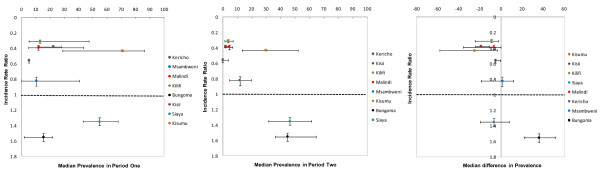
Relationship between changes in the incidence rate of malaria admissions between period one and two (Incidence rate ratio) and equivalent absoulte changes in transmission intensity across 8 hospital sites in Kenya (Left-starting PfPR; Middle - PfPR at the end of the study and Right - absolute difference in prevalence between period one and two).